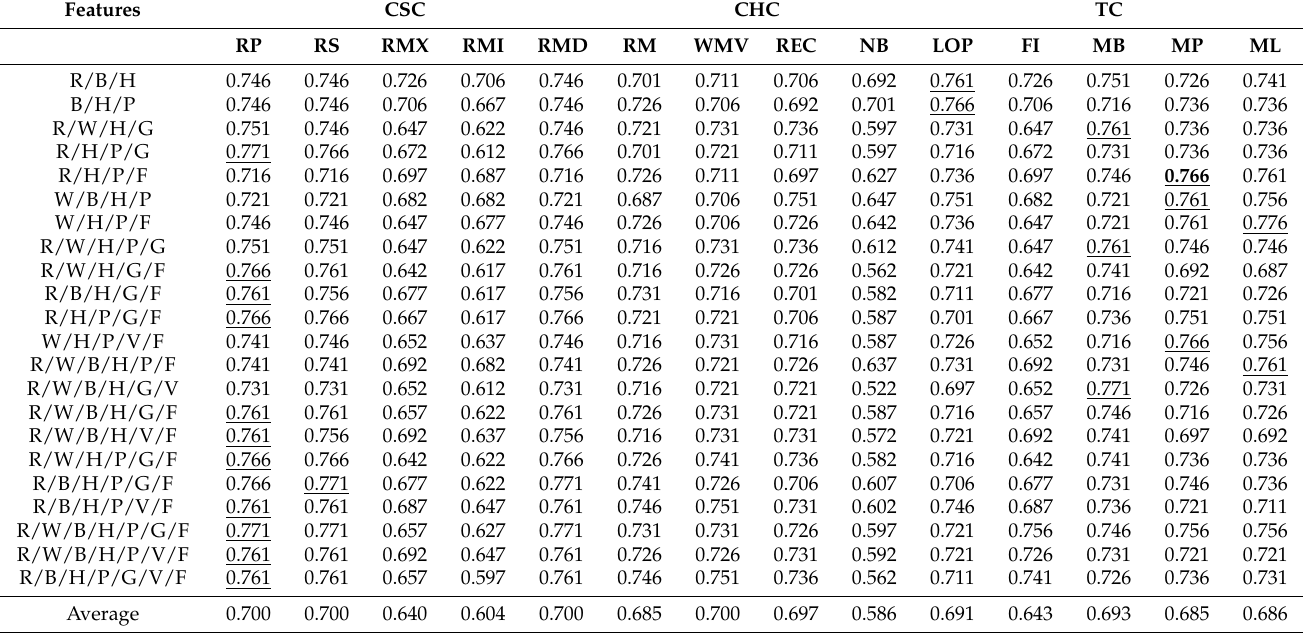
Table 5. Accuracy selection greater than 0.776 for 14-rule combination methods and 247